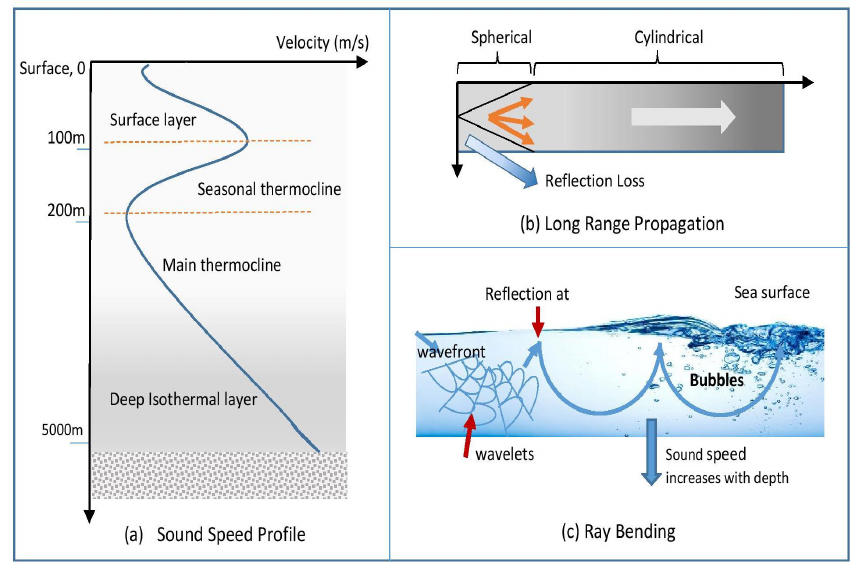
Figure 7. Sound Velocity